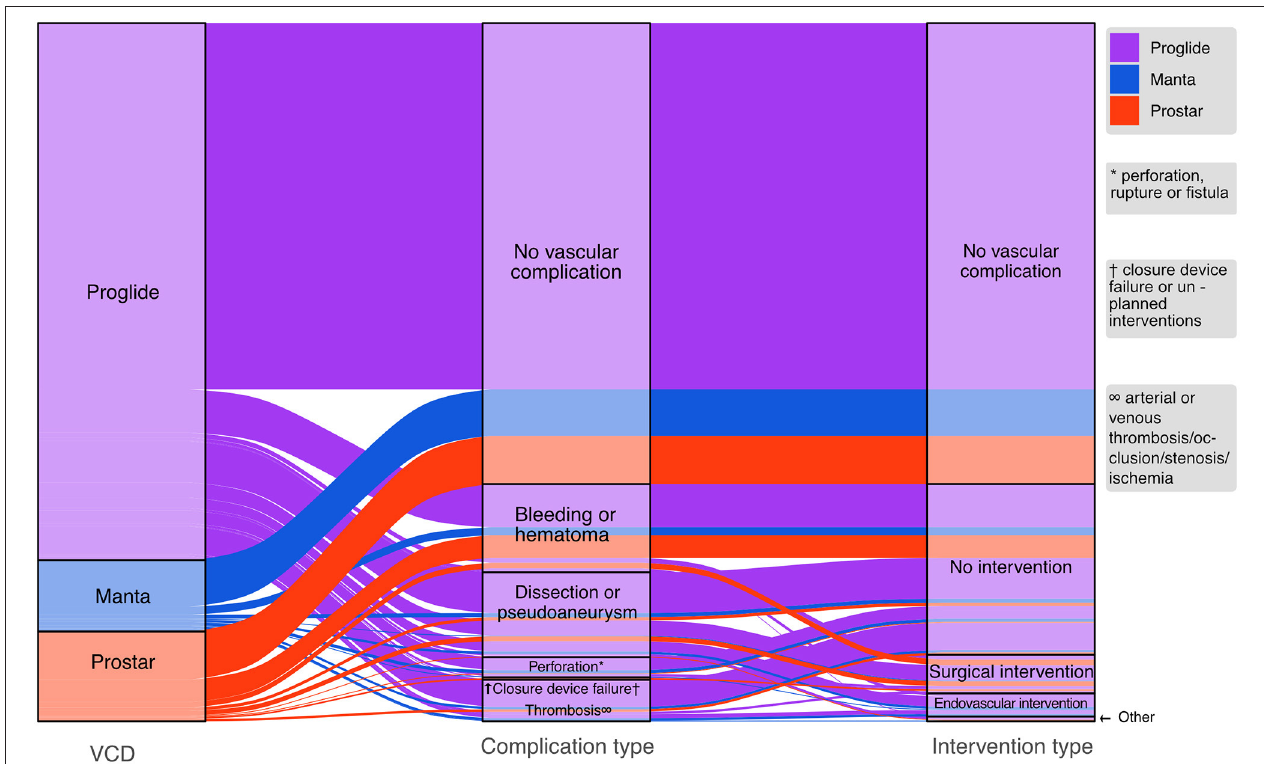
FIGURE 1 | Alluvial diagram displaying the proportion of utilized vascular closure devices (VCD) (left part) and the vascular complications that occurred within each VCD group (middle part). The right part indicates how each vascular complication was treated.